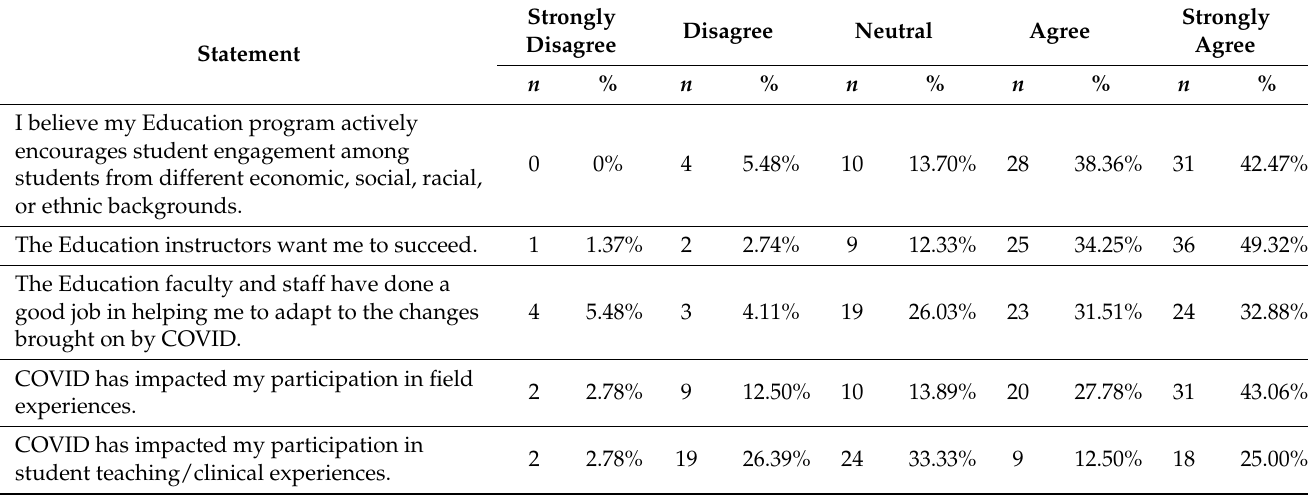
Table 5. Perceptions of Components within Teacher Preparation